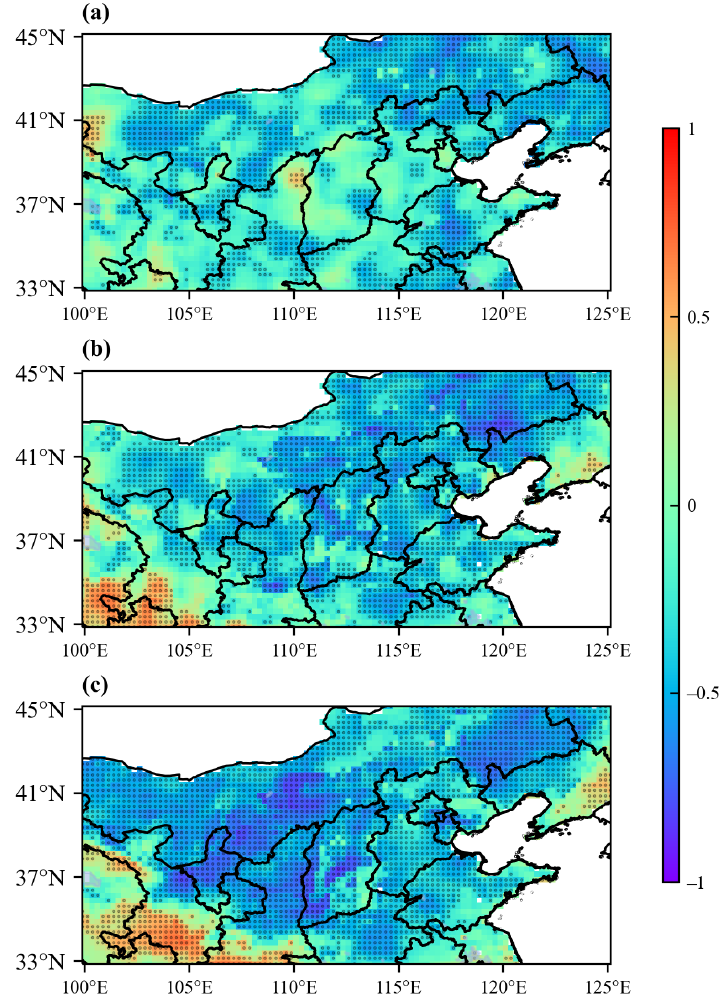
Figure 15. Distribution of correlation coefficients between ( a ) P and LCL, ( b ) ET and LCL, ( c ) ET and BLH (dot denotes correlation coefficient passing 0.05 significance test).